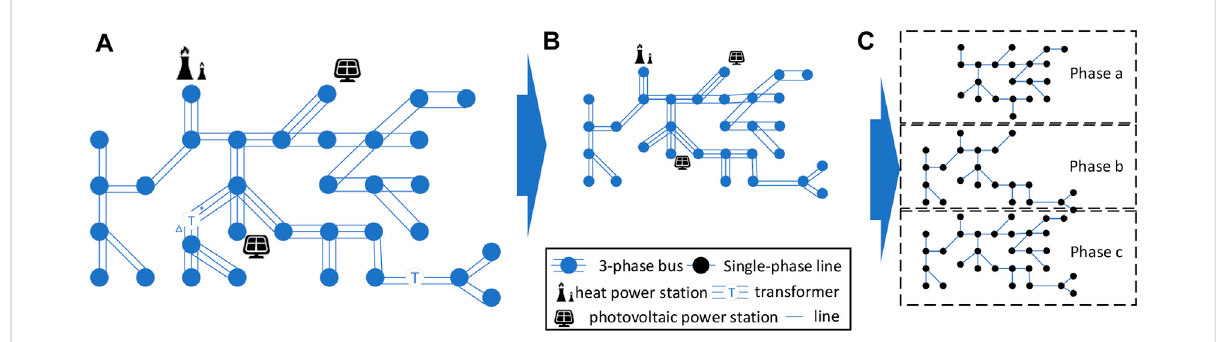
FIGURE 2 Flowchart of dividing the distribution network into three independent